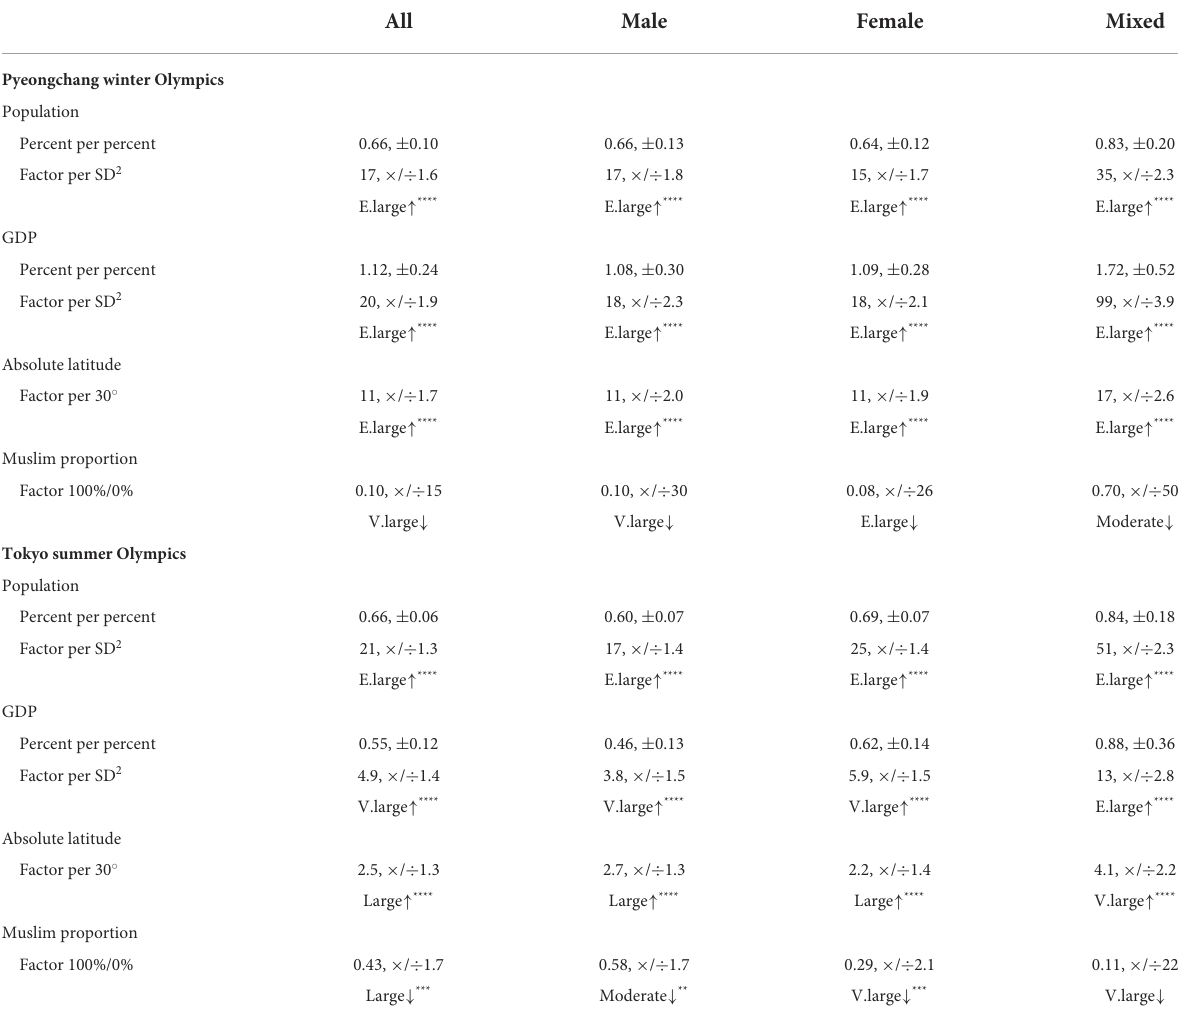
TABLE 3 Effects of population, gross domestic product per capita (GDP), absolute latitude and proportion of Muslims on medal counts in all, male, female and mixed events provided by multiple linear Poisson regression for the Pyeongchang winter Olympics and the Tokyo summer Olympics. All Male Female Mixed